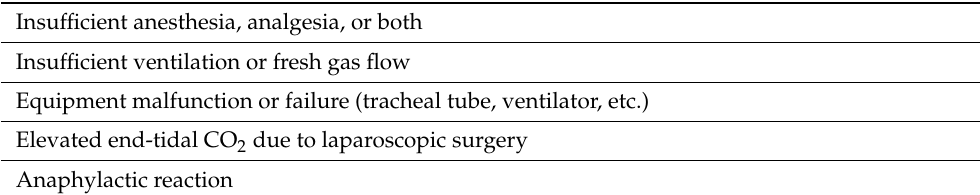
Table 1. Differential diagnosis of malignant hyperthermia. Insufficient anesthesia, analgesia, or